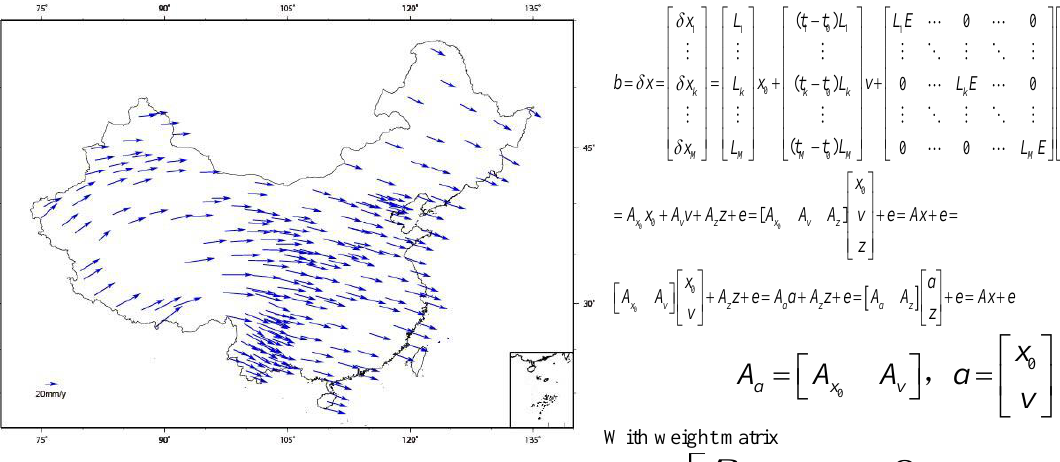
Figure 2. The velocity of national CORS stations (CGCS2000)